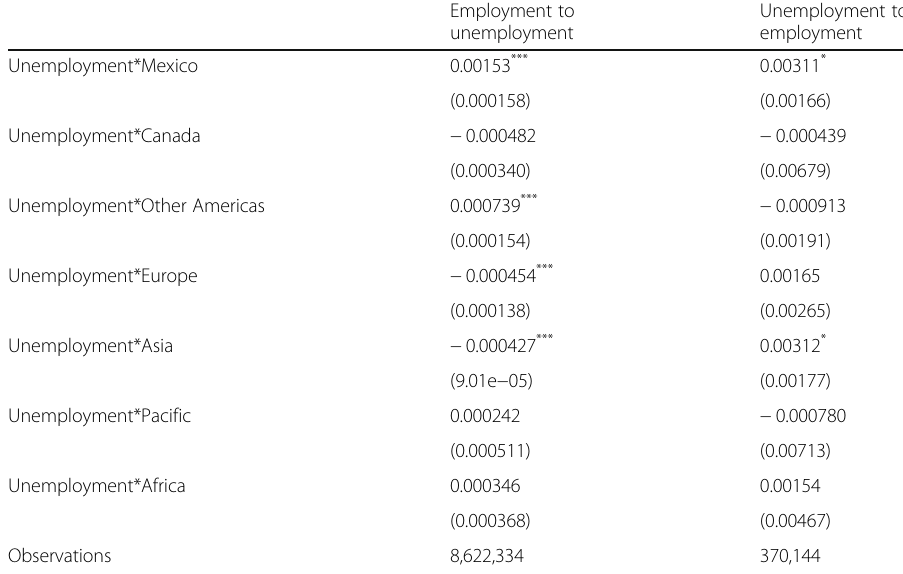
Table 7 Two-way transitions by country of origin: matched CPS data, 1996 –